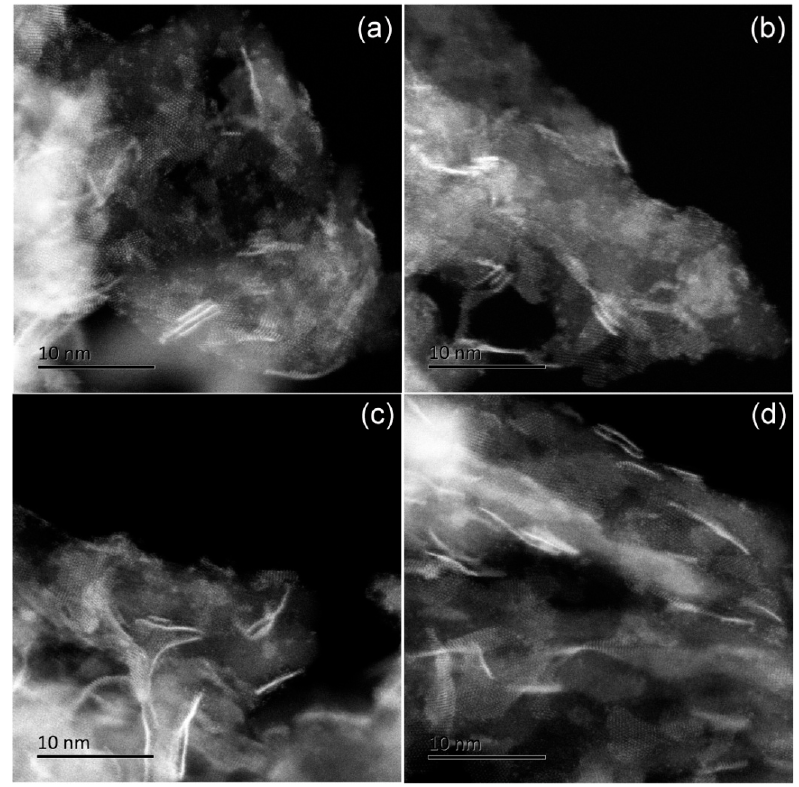
Figure 2. Aberration-corrected (Cs)-STEM-HAADF images of commercial NiMo/ γ -Al 2 O 3 catalysts,